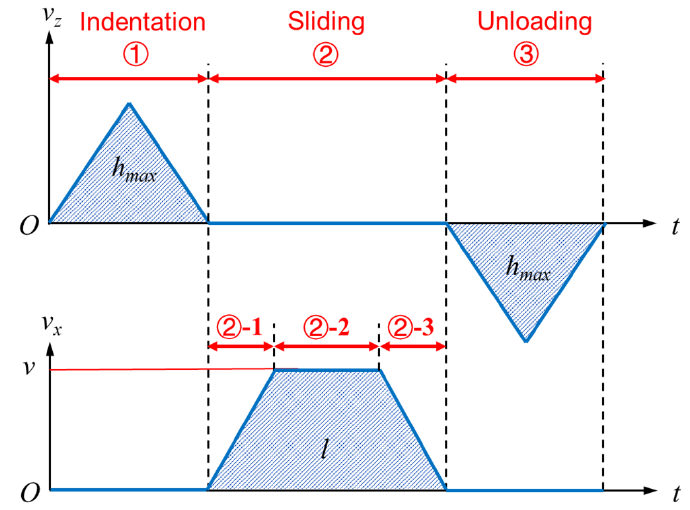
Figure 3. The velocity of the indenter during the FEA of